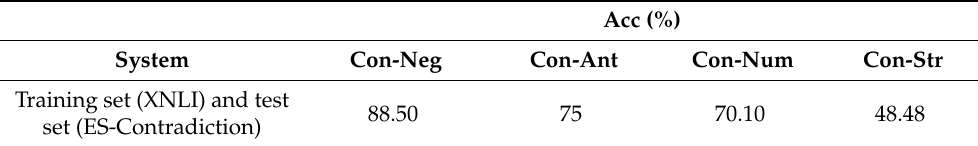
Table 8. Accuracy obtained for detecting each specific type of contradiction with the model in row 1 of Table